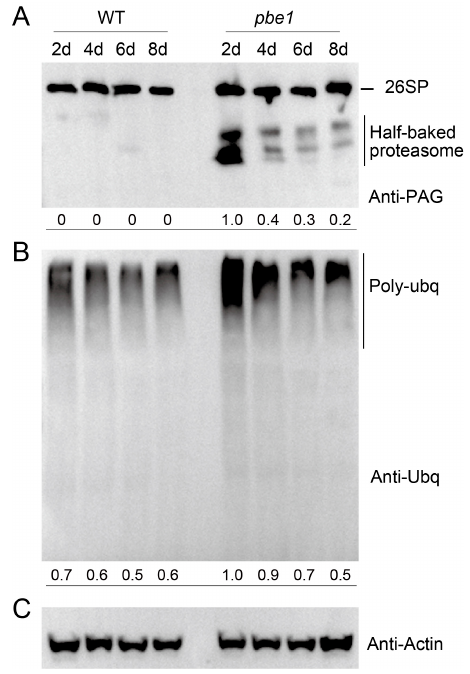
Figure 1. Mutations in PBE1 cause Arabidopsis proteasome dysfunction. Proteasome assembly and protein polyubiquitination levels were detected in the wild-type (WT) and pbe1 mutant plants, which were grown on 1 / 2 MS media for 2, 4, 6, or 8 days. ( A ) Proteasome assembly was detected via native PAGE with an anti-PAG1 antibody. ( B ) Polyubiquitination of total protein was detected by SDS-PAGE and Western blotting with an anti-ubiquitin (Ubq) antibody. The numbers below indicate the relative abundance relative to the loading control (actin). ( C ) Actin was used as the loading